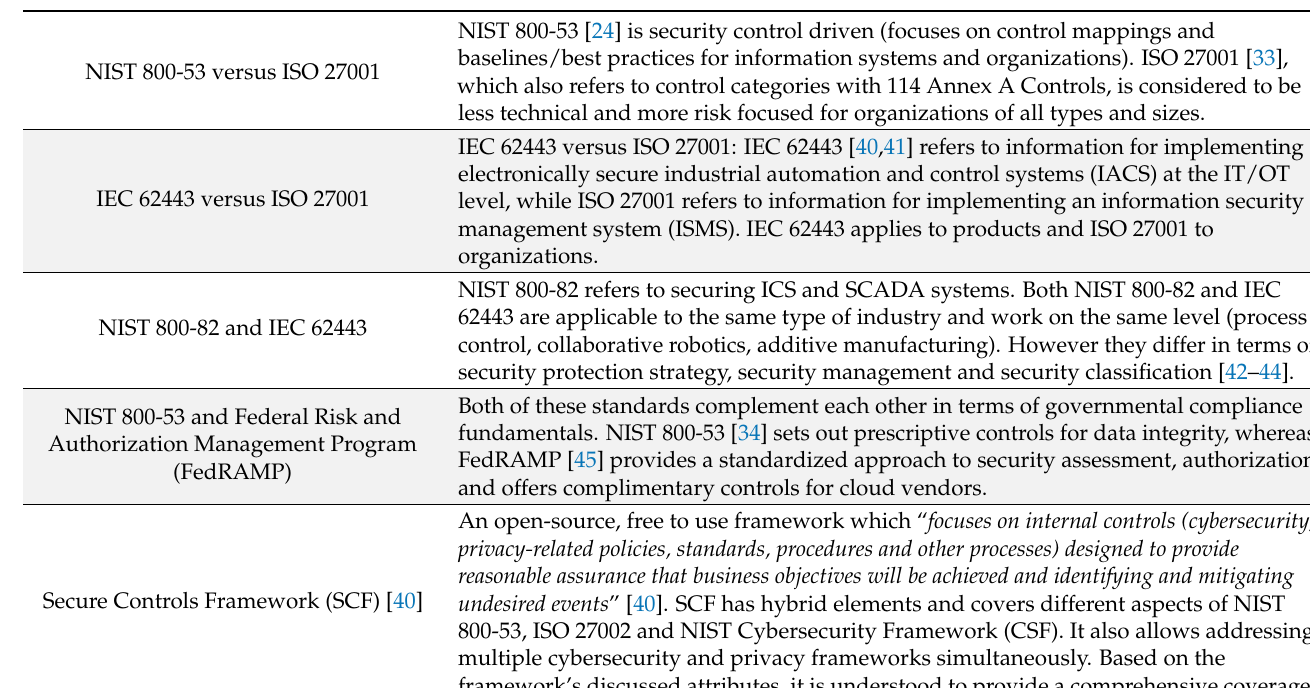
Table 2. Standards co-existence and comparison.